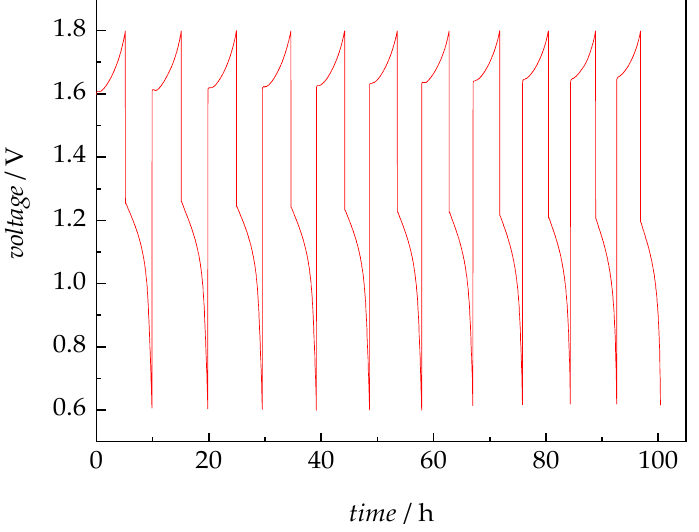
Figure 9. 10 charge and discharge cycles for #5.